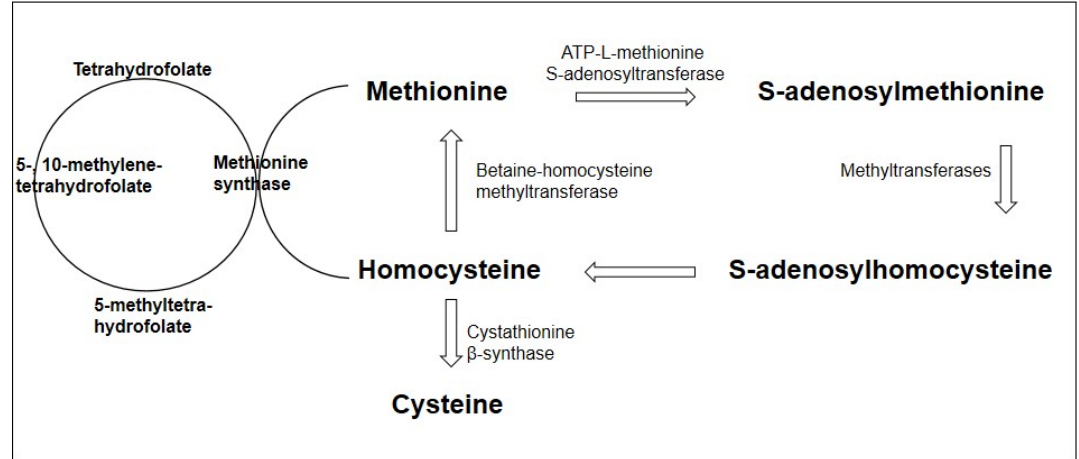
Figure 1. Homocysteine metabolism pathway (adapted from Esse et al., 2019 [19]). Hyperhomocysteinemia is defined as an increase in the plasma homocysteine concentration